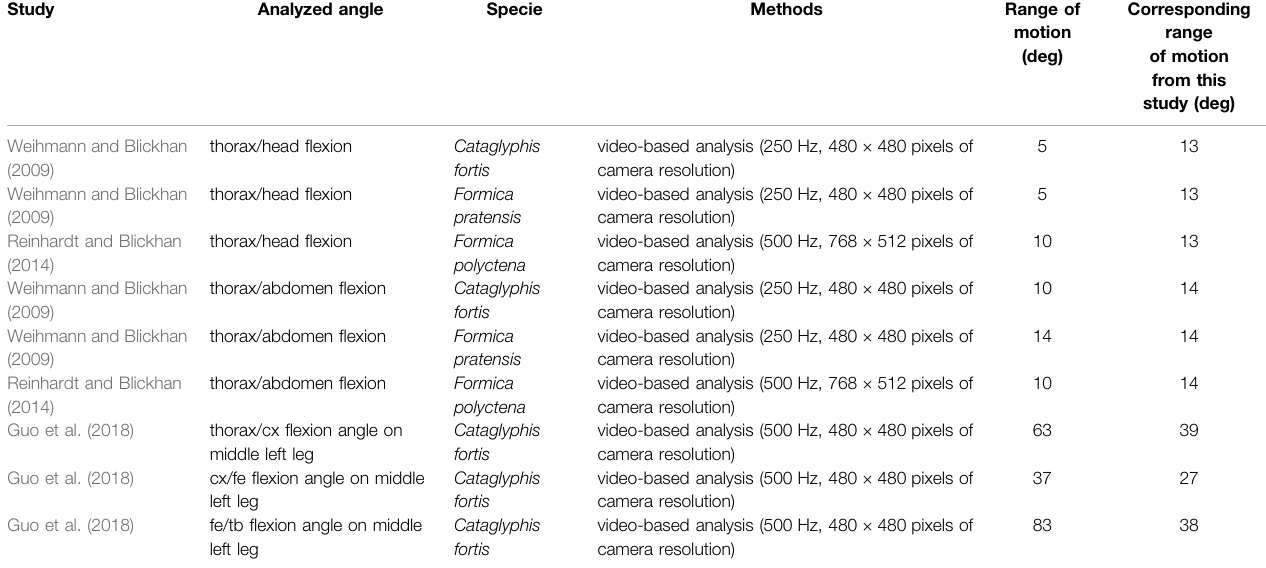
( Figure 7E ) ti/mt, and ( Figure 7F ) mt/ta fl exion angles]. Mean values (in solid lines) from both MC simulations (marker and axis perturbations) are shown with their corresponding con fi dence intervals (shaded regions). The green line and shaded region represent the results from the marker perturbation, and the blue line and shaded region represent the results from the axis perturbation. The SNR of the thorax/cox fl exion angle obtained from the axis perturbation simulation is illustrated in Figure 7A